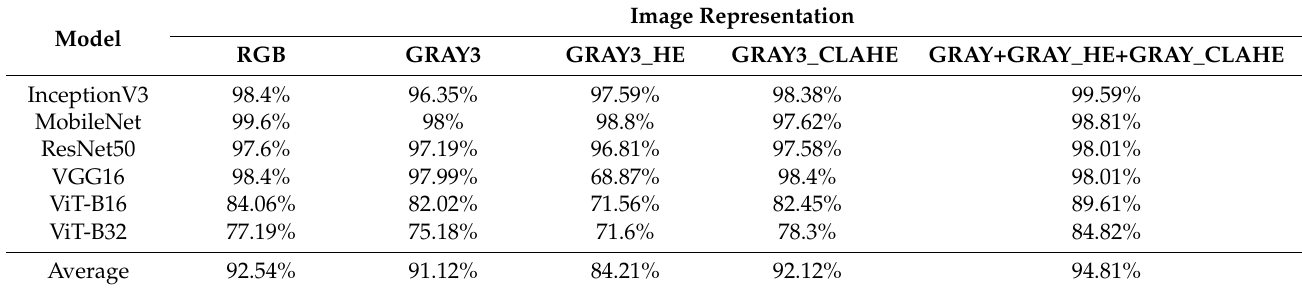
Table 5. Recall of the models across various image representations.